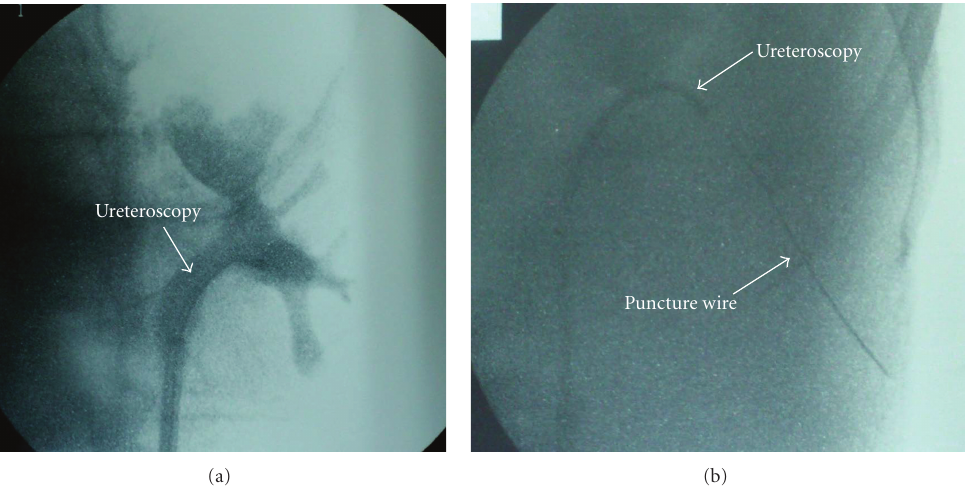
Figure 2: Retrograde pyelography (a) and advancing puncture wire to the skin (b).